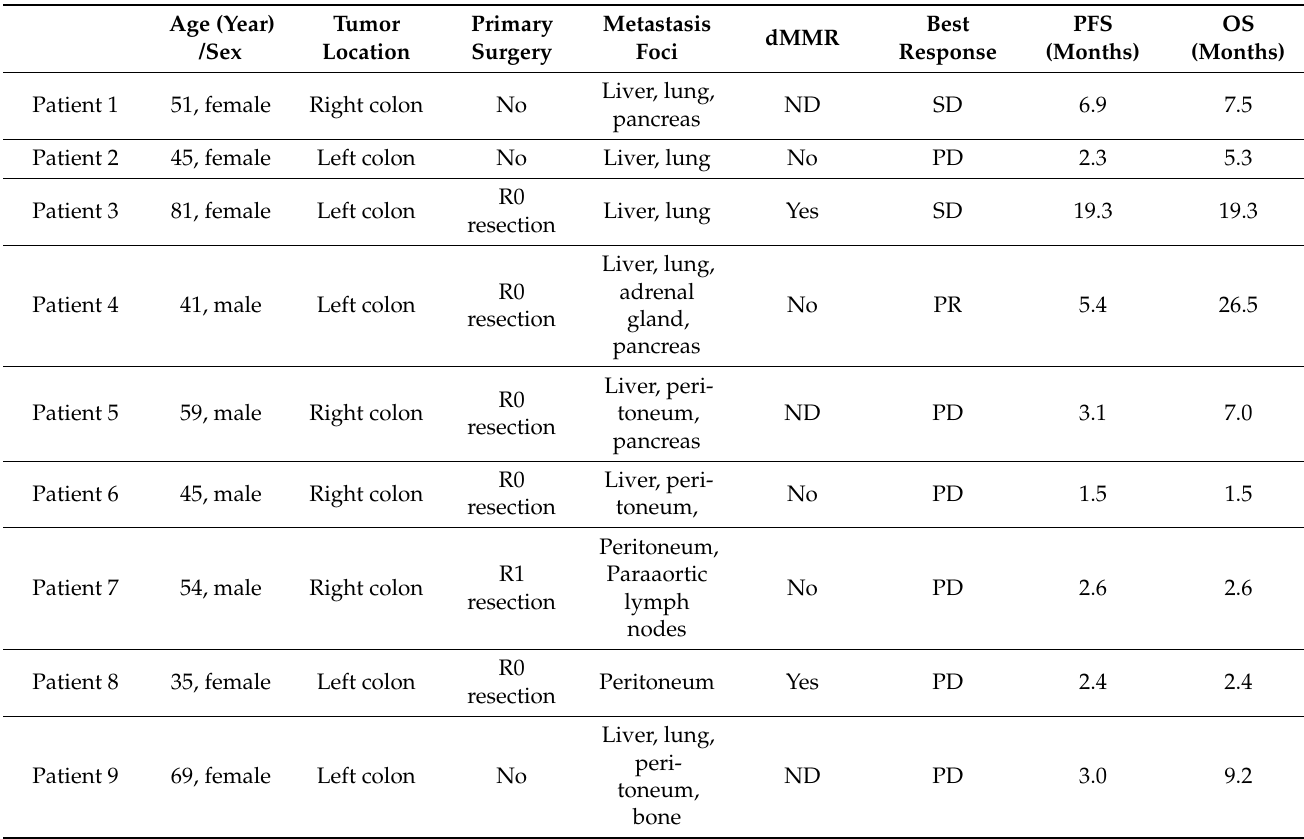
Table 2. dMMR status, treatment responses, and survival of each patient with BRAF -mutated mCRC receiving triplet therapy.